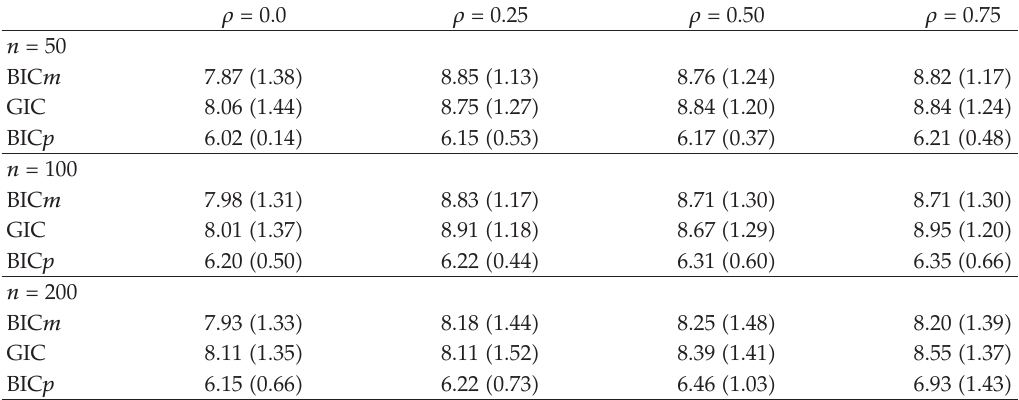
Table 4: Means (cid:3) standard deviations (cid:6) of the number of basis functions. ρ (cid:7) 0 . 0 ρ (cid:7) 0 . 25 ρ (cid:7) 0 . 50